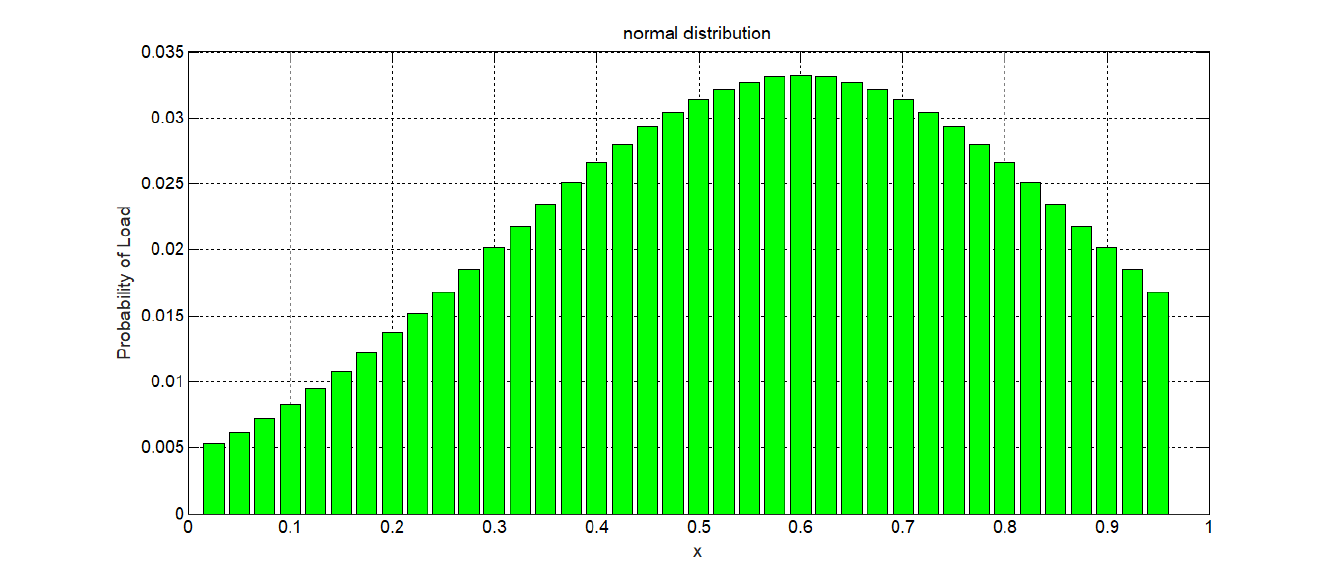
Fig. 2. PDF of photovoltaic cells (irradiance)